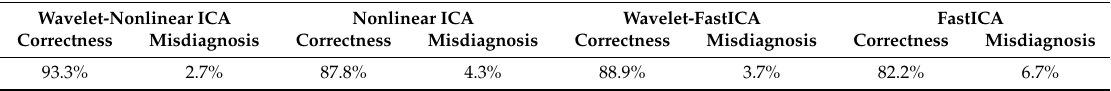
Table 3. Comparison of diagnostic performance of di ff erent diagnosis methods.